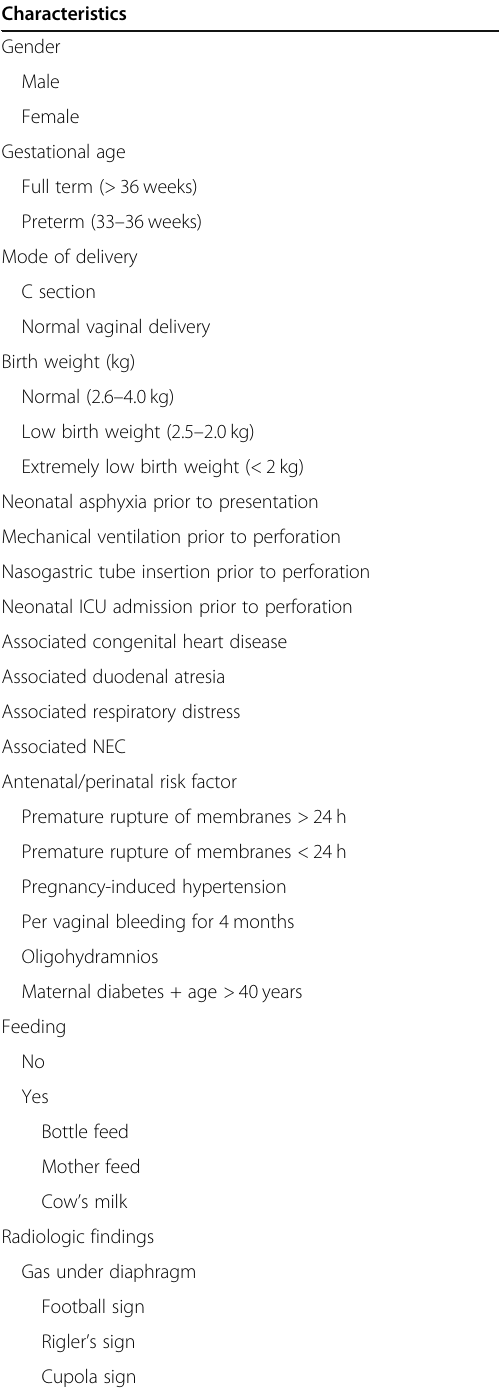
Discussion Our study population consisted of 29 males and 17 fe- males with ratio of M:F=1.7:1. Gupta et al. and Kara et al. showed different results with gender distribution.